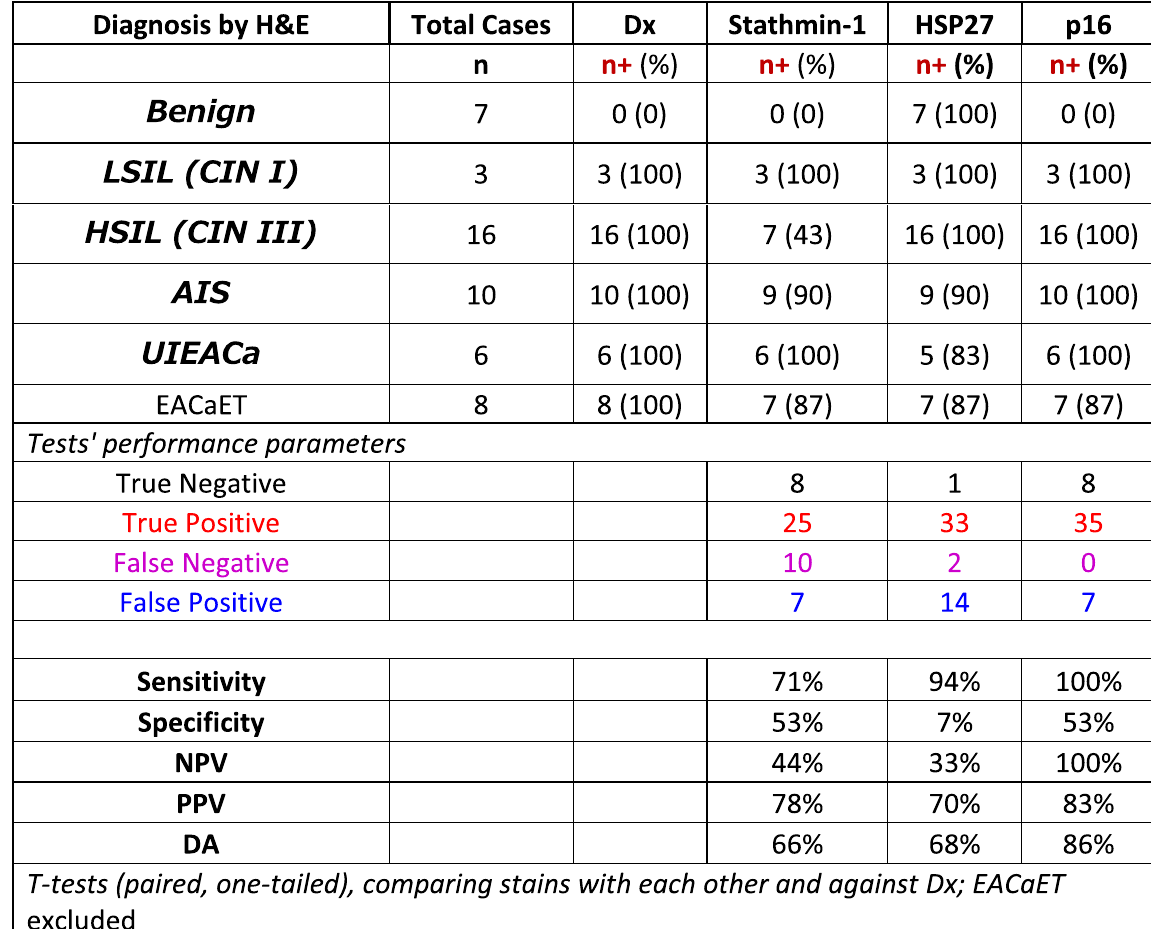
Table 1 Test performance and T-test analyses of the stains in the HPV surrogate